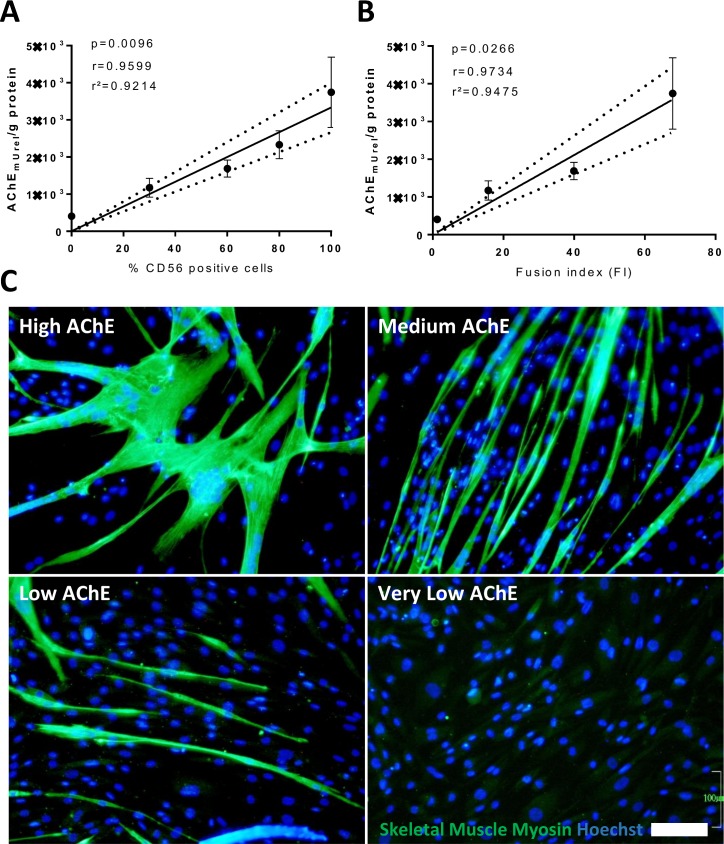
Comparison of AChE activity with CD56 expression and fusion competence.AChE activity per g of total protein was determined in SMDC populations derived from at least three different patients with different percentages of CD56+ cells after 6 days of differentiation on gelatin coated 24-well plates. Correlation between AChE and CD56 expression in SMDCs by Pearson linear regression analysis of at least 4 different patient samples results at a p-value of p = 0.0096, a correlation coefficient of r = 0.9599 and coefficient of determination of r2 = 0.9214. Data points were presented as mean±SEM AChE activity. 95% confidence intervals are shown as dotted lines (A). Correlation between AChE and fusion index (FI) of SMDCs by Pearson linear regression analysis of at least 4 different patient samples resulted in a p-value of p = 0.0266, a correlation coefficient of r = 0.9734 and coefficient of determination of r2 = 0.9475. Data points presented as mean±SEM AChE activity and mean±SEM fusion index of four different patient samples in a total of 16 mixtures of fusion competent and non-fusogenic cells. 95% confidence intervals are shown as dotted lines (B). SMDCs from 4 patients resulting in a total of 16 SMDCs populations grouped in “High AChE”, “Medium AChE”, “Low AChE” and “Very low AChE” according to their mean±SEM AChE activity of 4421±540, 1774±176, 1302±179 and 398±27 AChEmUrel/g protein, respectively stained for SK-Myosin expression after 6 days of differentiation on gelatin-coated 24-well plates. Scale bar = 100 μm (C).